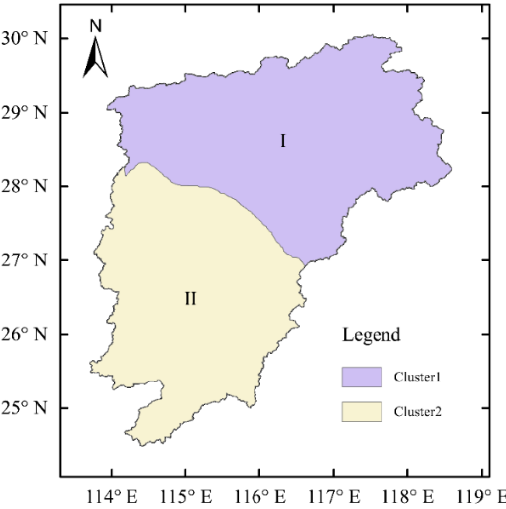
Figure 4. The cluster based on the meteorological stations’ precipitation data in the Poyang Lake basin.